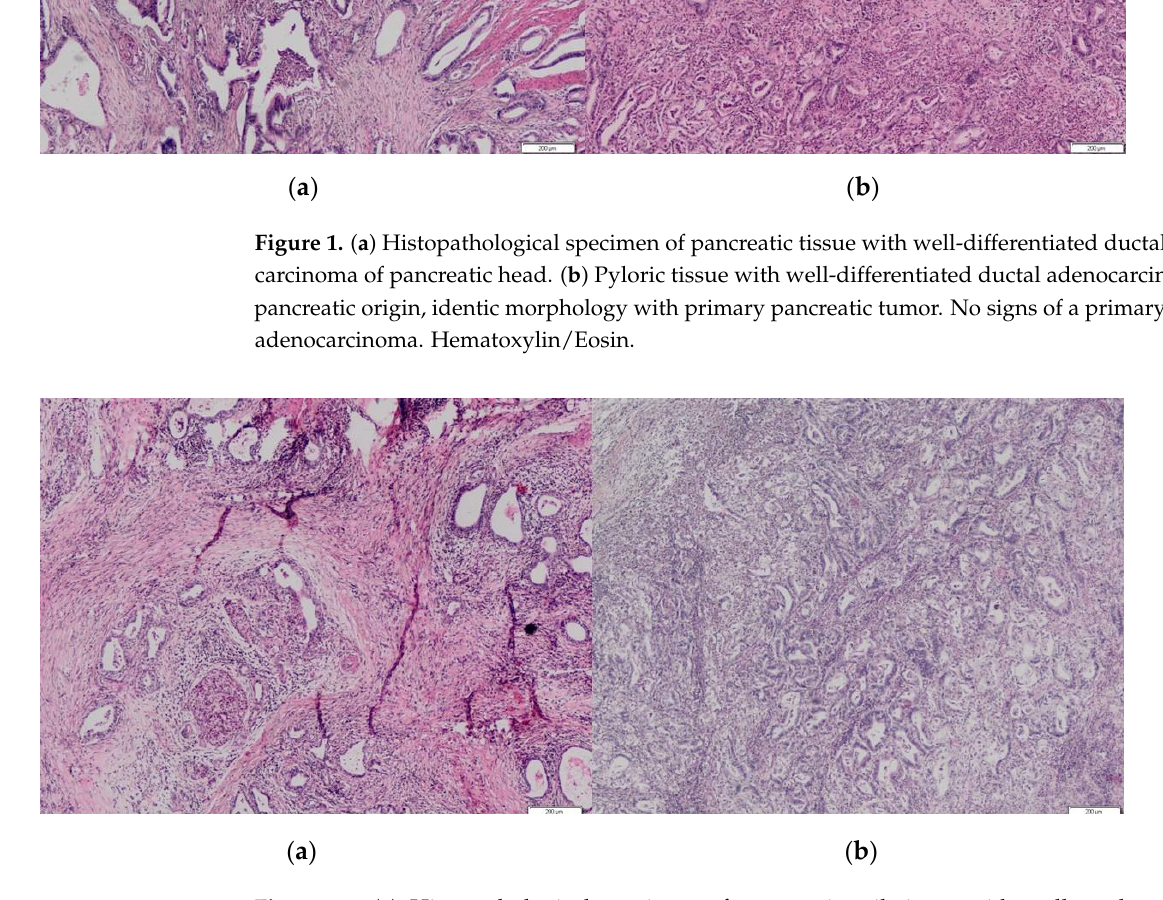
Figure 2. ( a ) Histopathological specimen of pancreatic tail tissue with well- and moderate- differentiated ductal adenocarcinoma. ( b ) Posterior stomach wall tissue with well- and moderate-differentiated ductal adenocarcinoma. Identical morphology with a primary pancreatic tumor. No signs of primary gastric adenocarcinoma. Hematoxylin/Eosin.